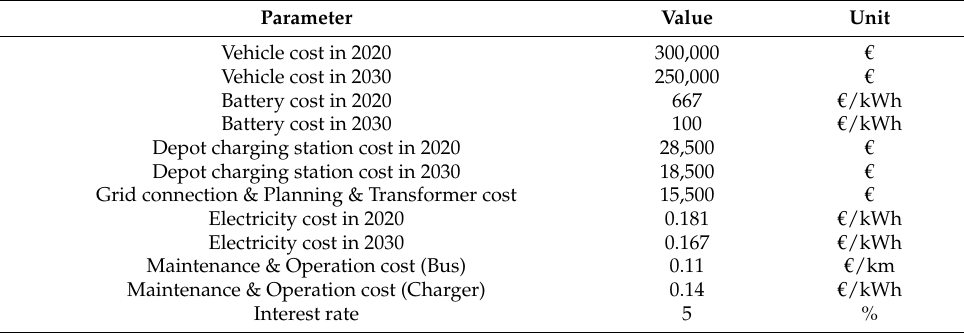
Table 4. Economical parameters for the depot charging